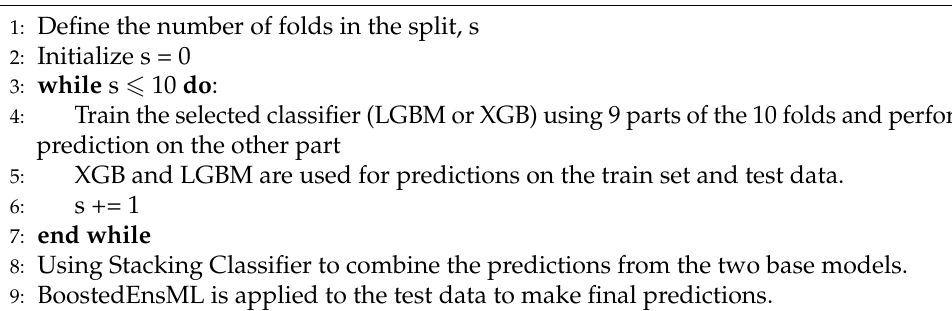
Algorithm 3 The algorithm for the